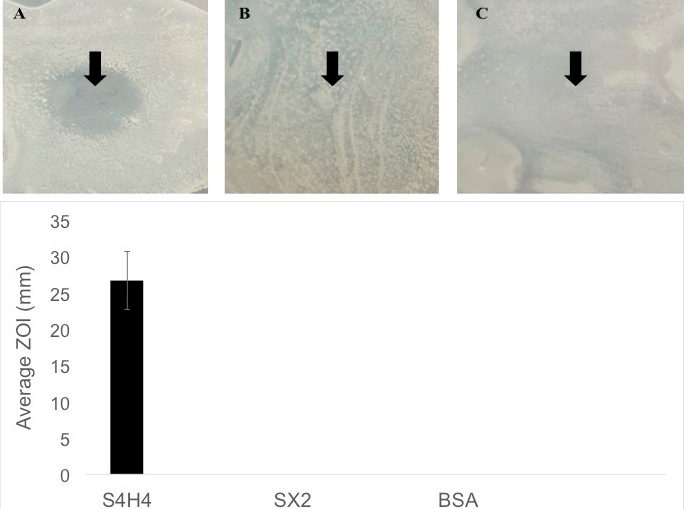
Figure 5 Figure 5. Zone of inhibition of fusion protein compared with other controls. ( A ) S4H4, ( B ) SX2, and ( C ) BSA (included as a negative control). Note that the same amount of protein was spotted (indicated by the arrow) for each sample. The average (n = 3) measured zone of inhibition is shown in the bar graph below the representative images. No zone of inhibition was observed for either silk or BSA controls.